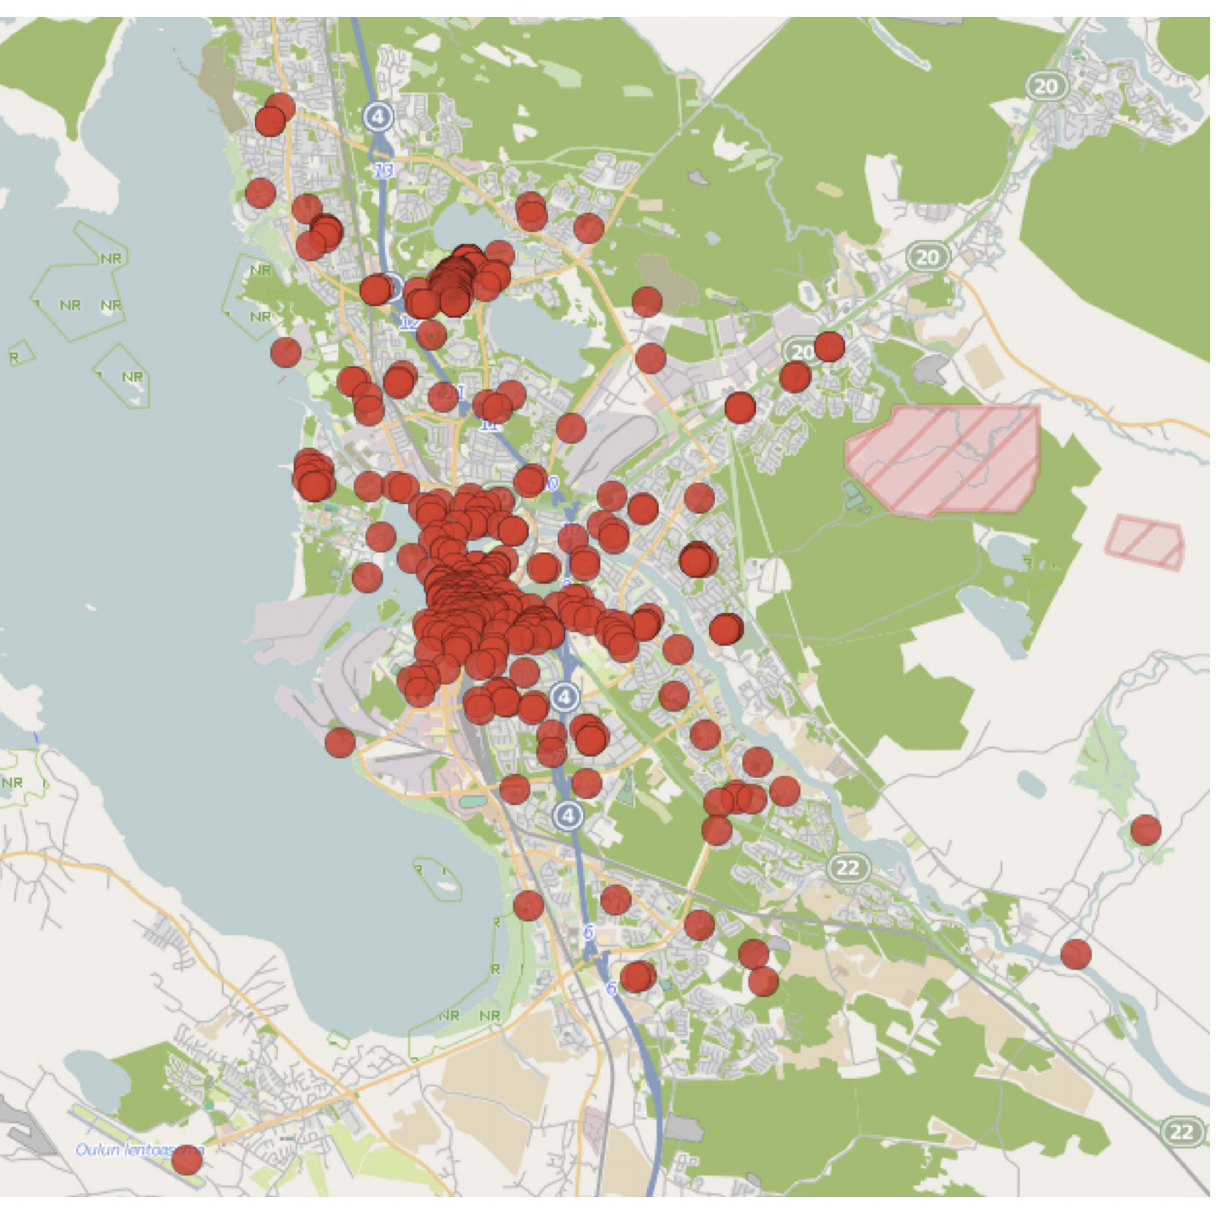
Figure 1. A map showing all the WiFi access point locations. The map covers an area approximately 20km 6 20km.